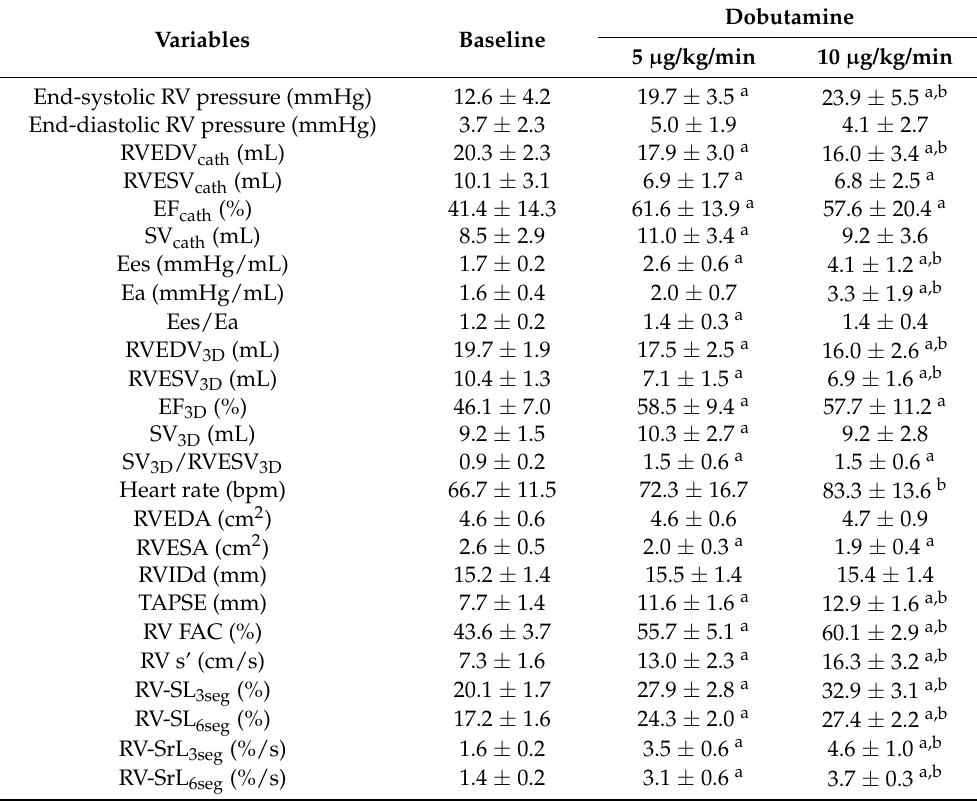
Table 1. Results of the changes in right ventricular morphology and functional variables obtained by right heart catheterization, real-time three-dimensional echocardiography, and two-dimensional echocardiography with dobutamine